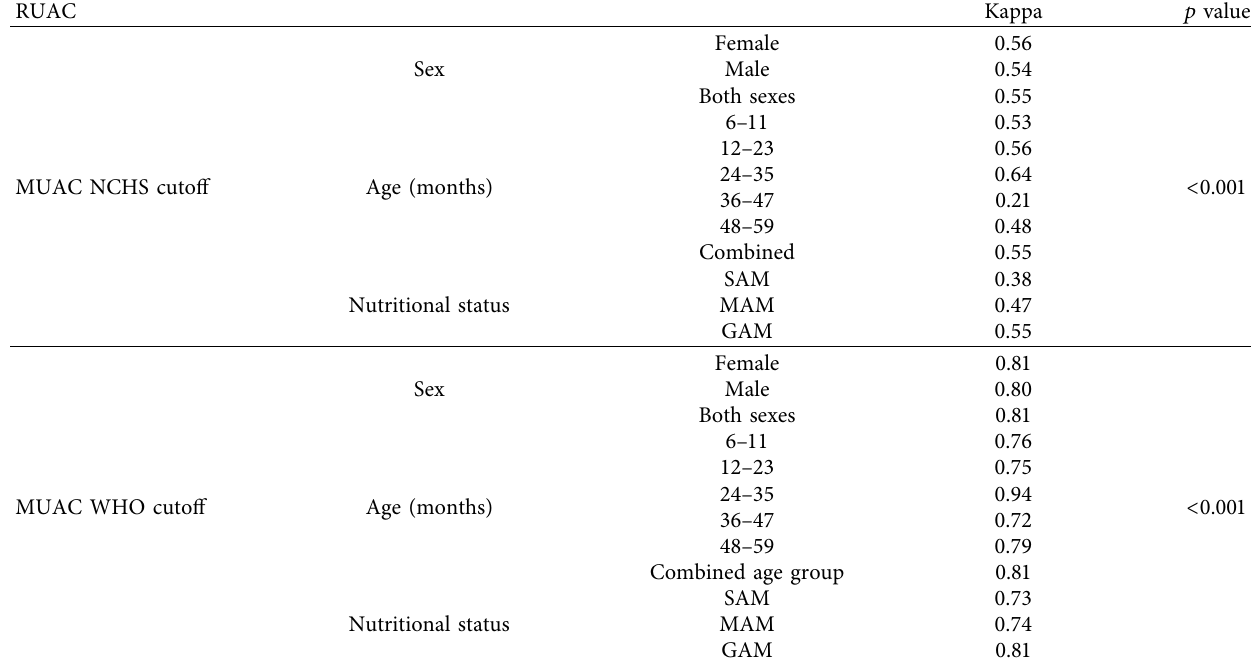
Table 3: Degree of agreement (kappa) between the two measurements for detecting acute malnutrition in 6–59-month-old children from Lanfro District, Southern Ethiopia, 2016 ( n �